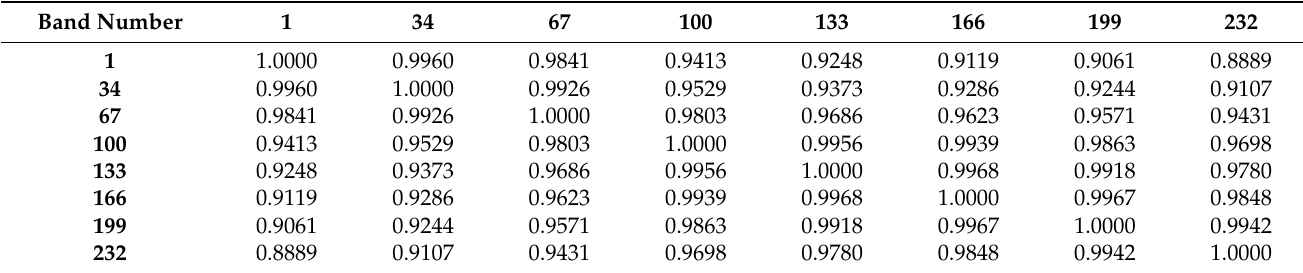
Table A2. Correlation coefficients matrix between 8